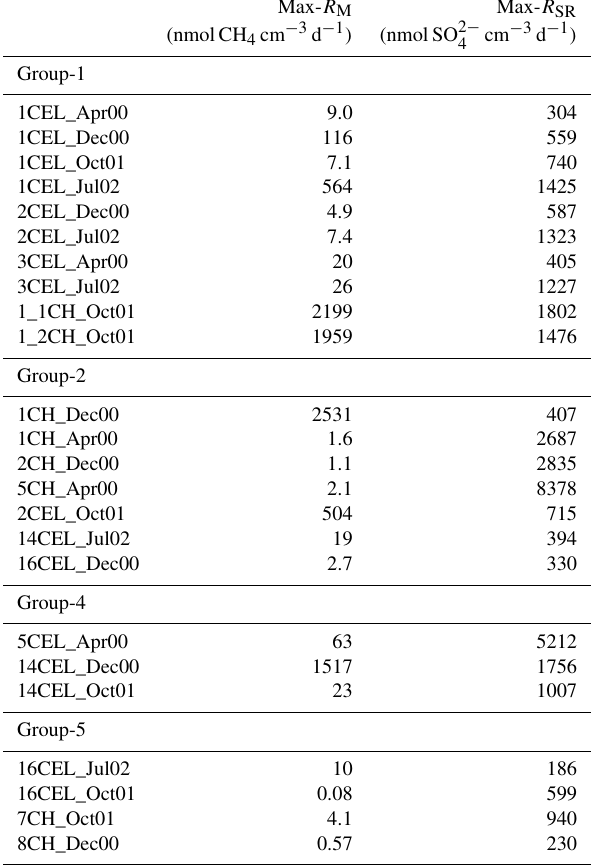
Table 3. Maximum model-derived rates of methanogenesis and sul- fate reduction for cores in Group-1 and maximum model-derived rates of methane production and sulfate consumption for cores in Group-2, Group-3 and Group-4. CEL and CH represent cores col- lected from Celestún Lagoon and Chelem